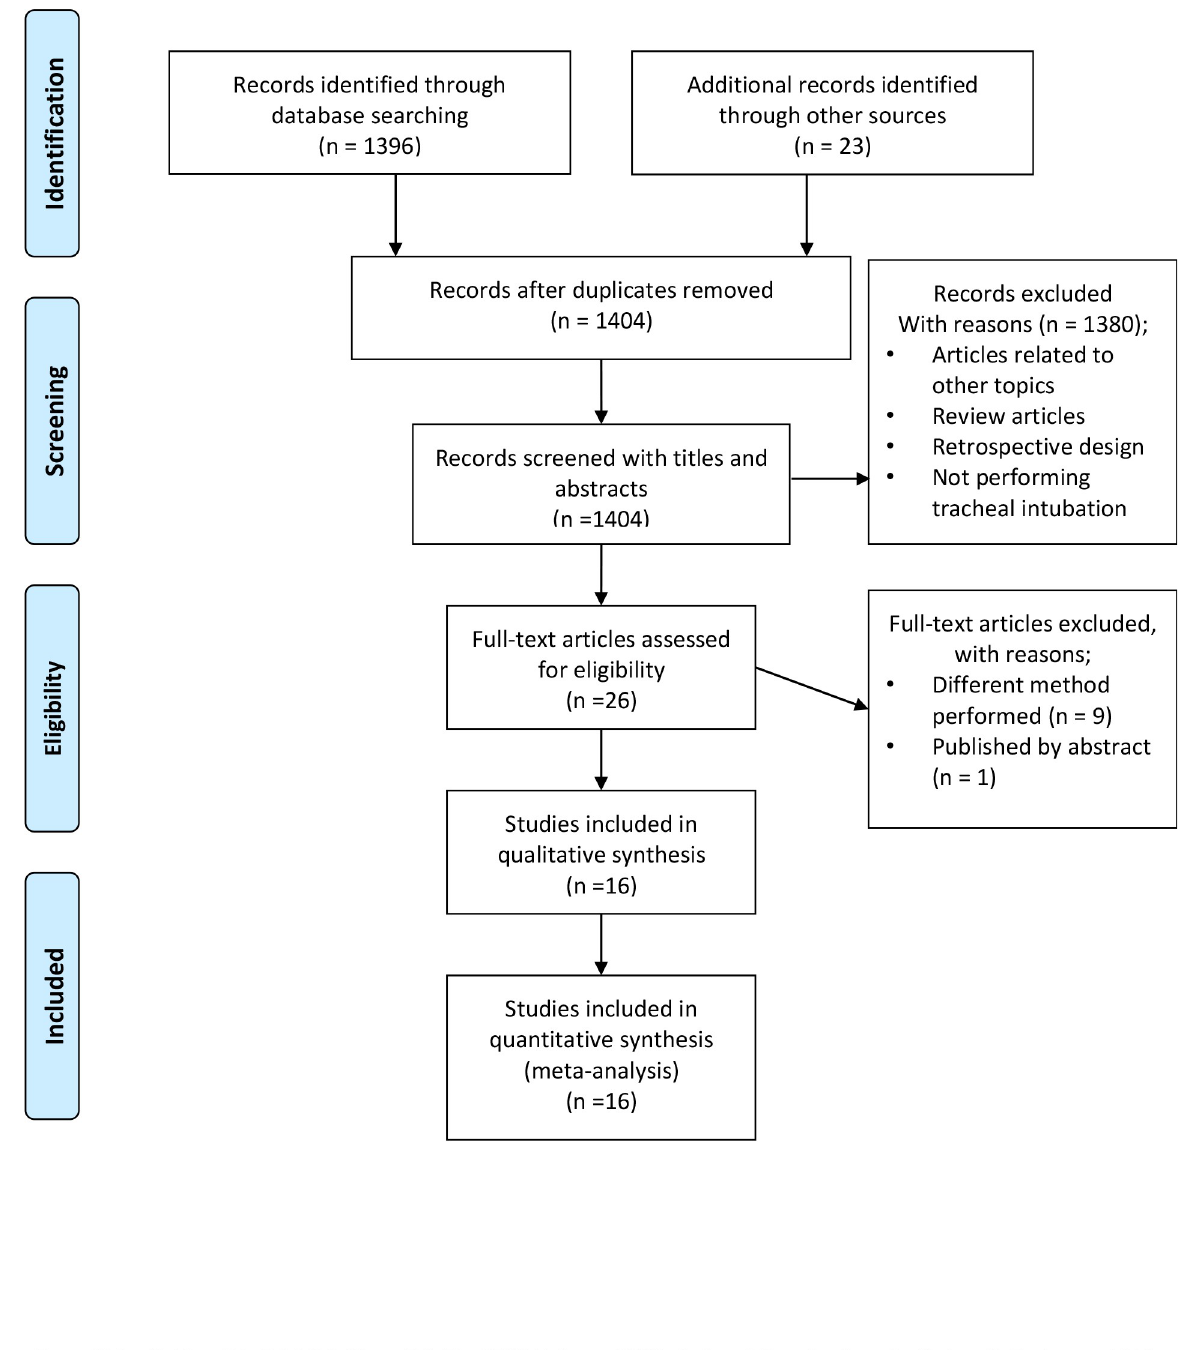
Fig 1. Flow diagram.